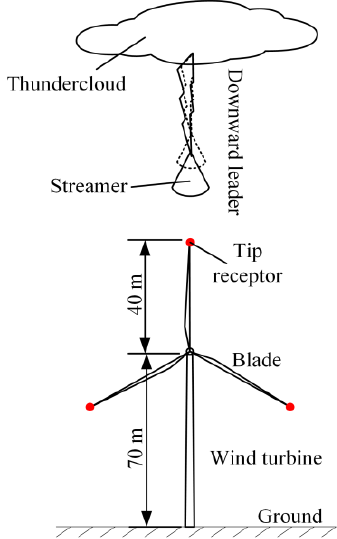
Figure 2. The schematic diagram of the position of the downward leader and the wind